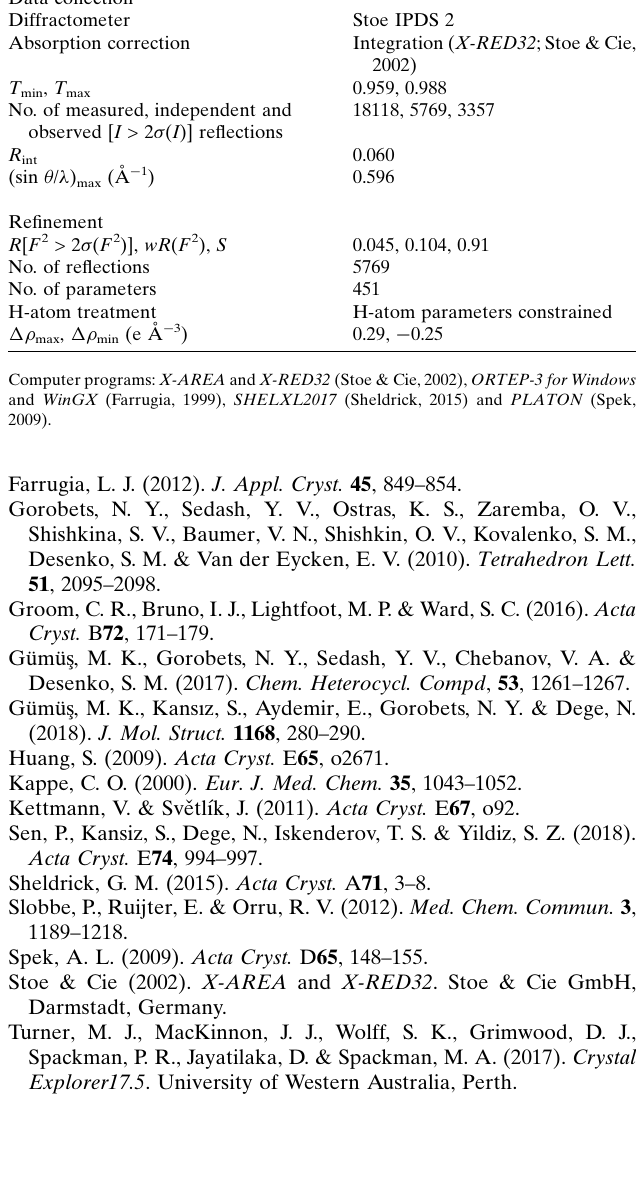
Figure 8 The synthesis of the title compound.